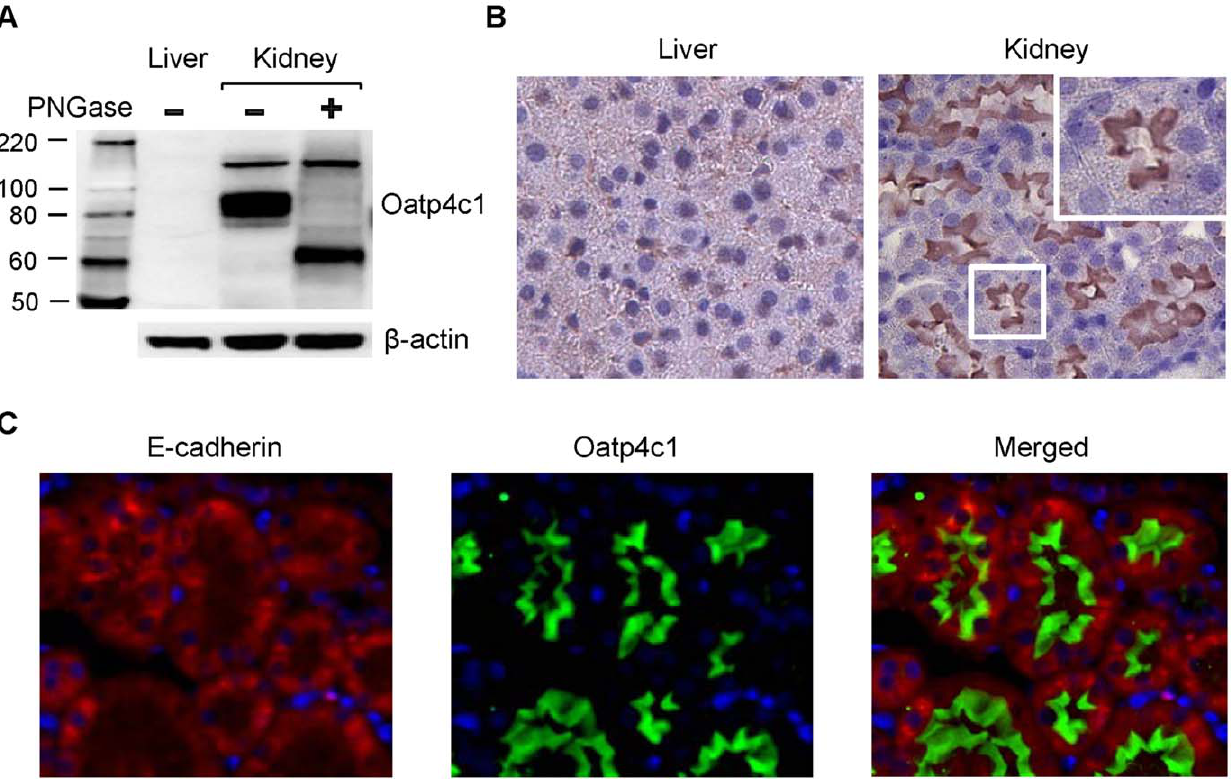
Figure 2. Oatp4c1 expression and localization in rat kidney. (A) Western blot analysis for Oatp4c1 expression in rat tissues. Crude membrane fractions from rat liver and kidney were prepared. PNGaseF was used for deglycosylation. Oatp4c1 was detected by PA1343. b -actin was used as a loading control. (B) Immunohistochemical analysis for Oatp4c1 subcellular localization in rat tissues. Paraformaldehyde-fixed paraffin-embedded rat tissue sections were stained with PA1343. Color development with NovaRed signifies Oatp4c1 staining. (C) Double immunofluorescence staining for Oatp4c1 (green) and E-cadherin (red) in rat kidney. E-cadherin served as a basolateral marker (Magnification: 40 6 ).